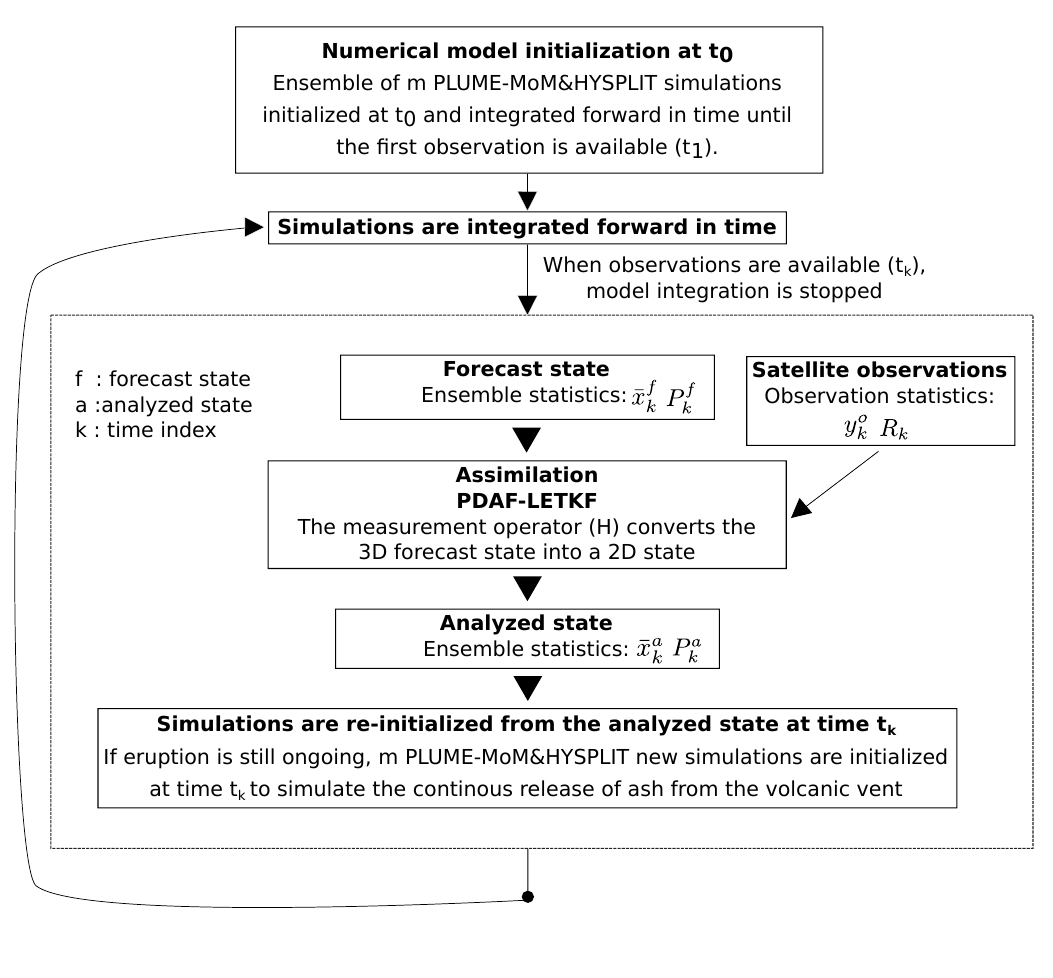
Figure 3. Workflow of the DA procedure developed for the present